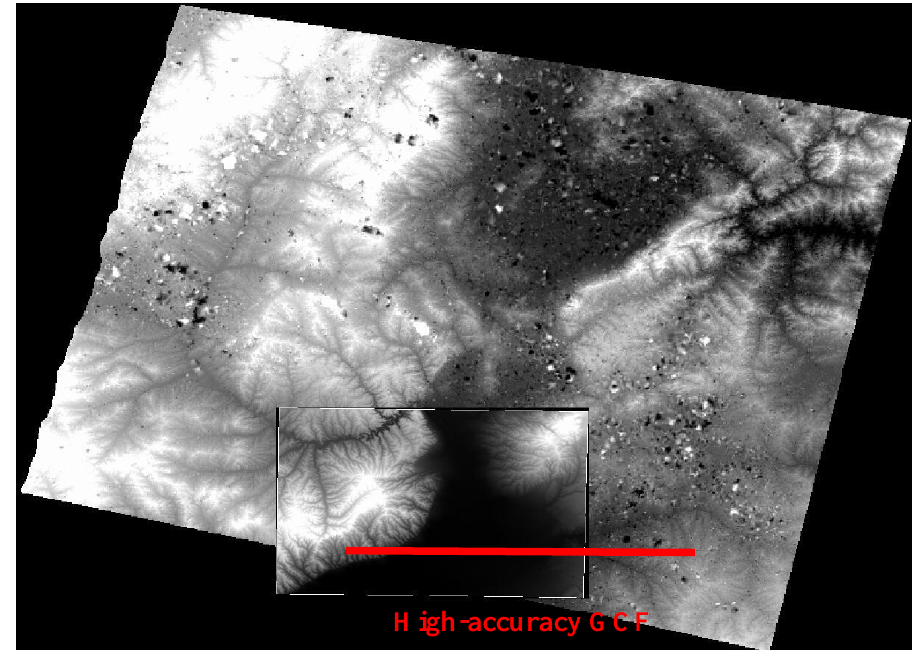
Figure 6. Geometric calibration field (GCF) spatial coverage. Figure 8. Geometric calibration field (GCF) spatial